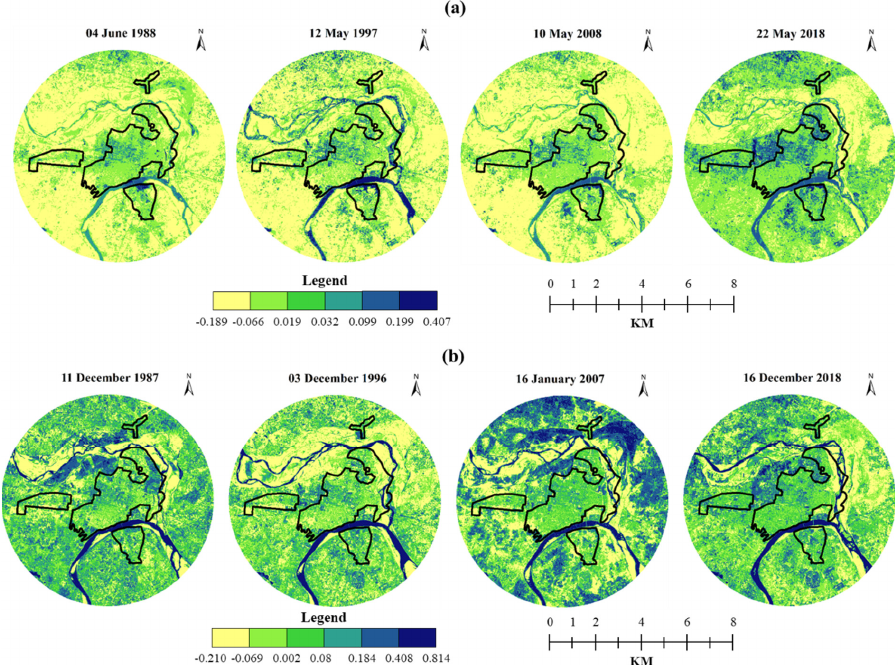
Figure 9. Seasonal NDMI dynamics in Prayagraj city (1987–2018): ( a ) summer and ( b ) winter.